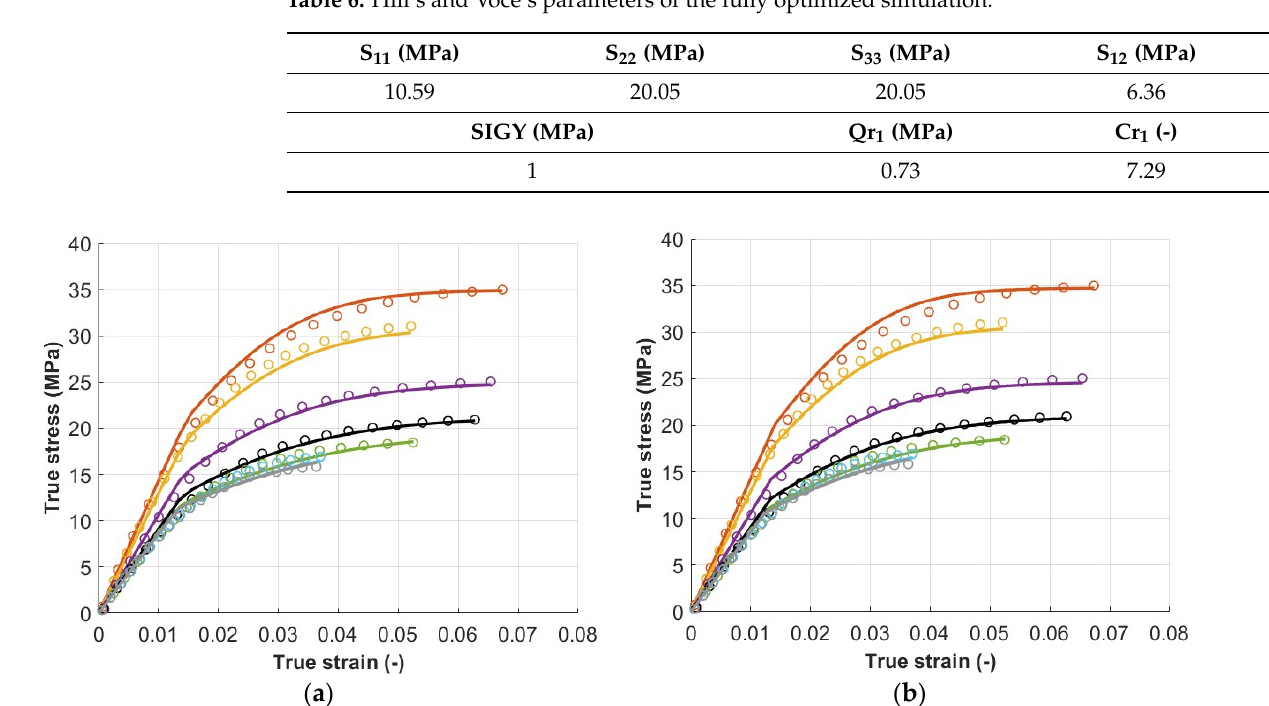
Figure 8. Comparison between experimental stress–strain curves ( σ ζ and ε ζ ) and numerical ones in the cases of Hill’s parameters directly identified from experimental data ( a ) and Hill’s optimized parameters ( b ). The MSE of the first case was 4.1 × 10 − 3 and that of the second case was 3.7 × 10 − 3 . Table 5. Voce’s parameters found from the simulation with Hill’s parameters directly identified from experimental data (as shown in Table 4).